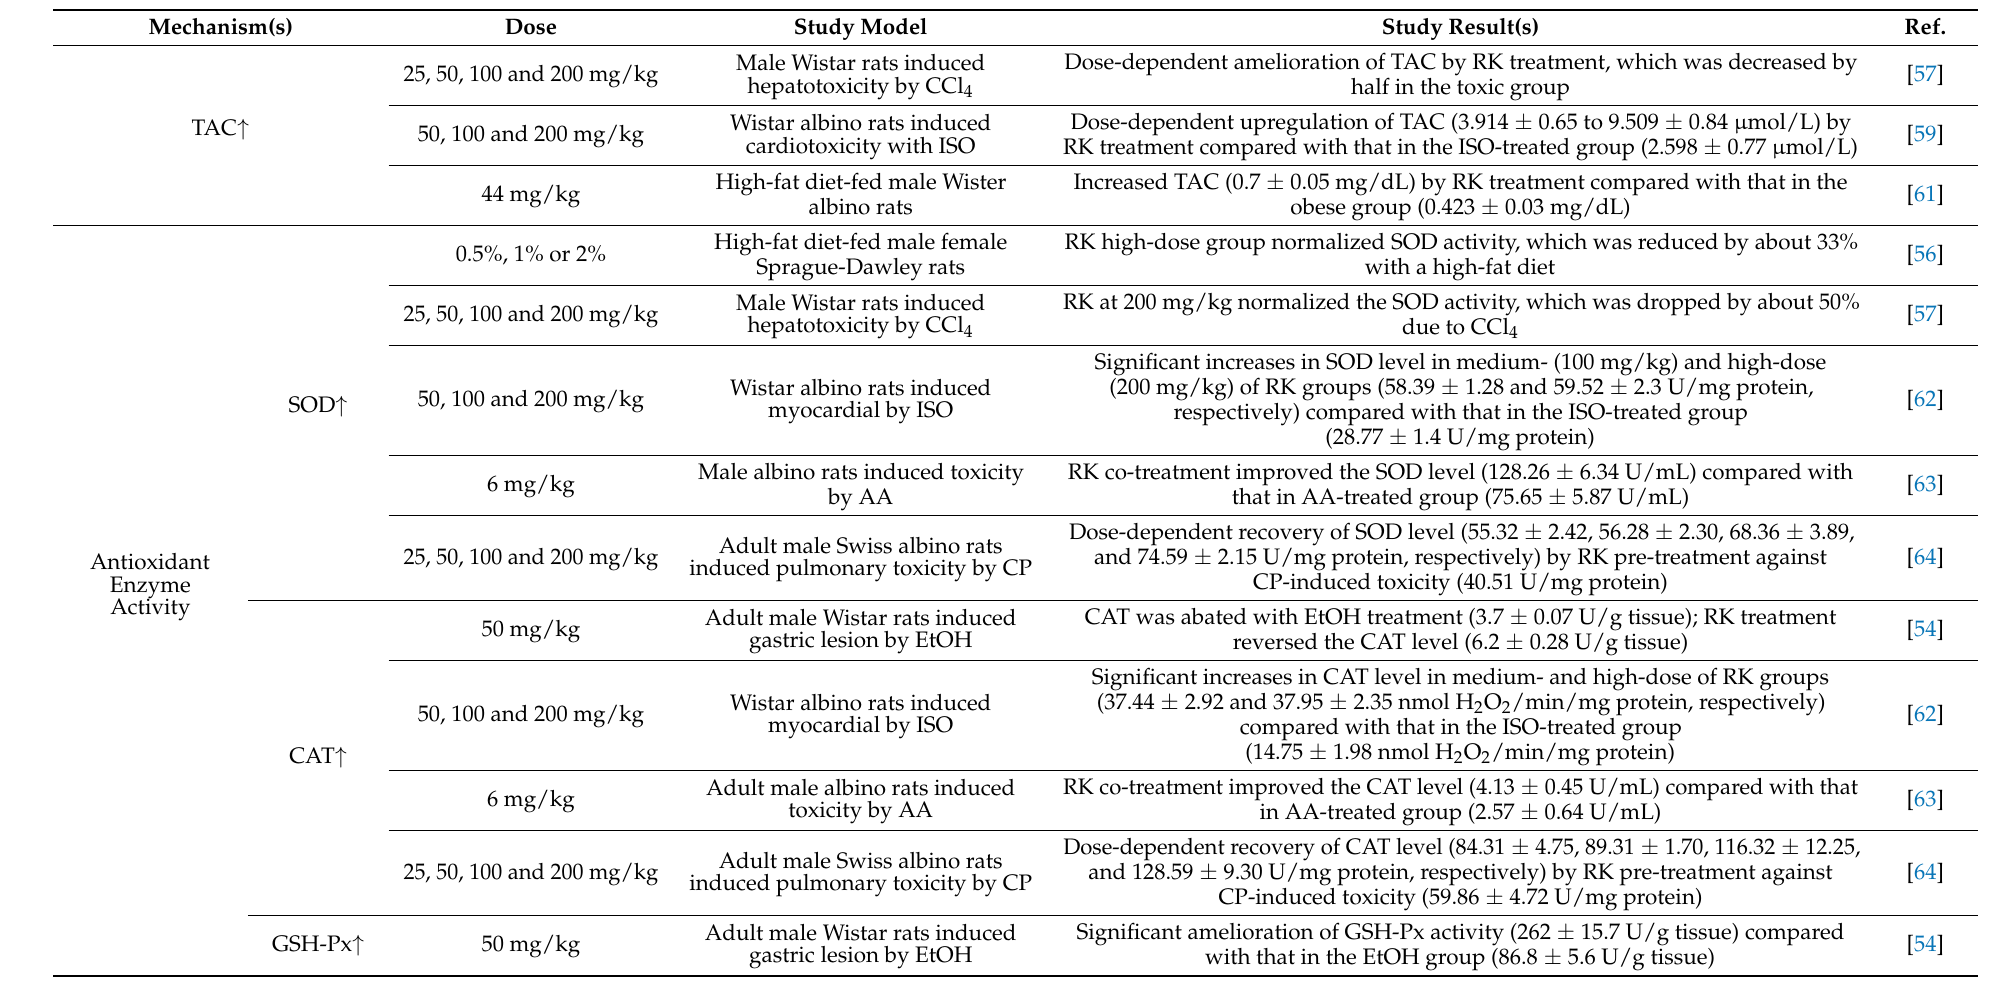
Table 1. Summary of antioxidant activities and underlying mechanisms of raspberry ketone